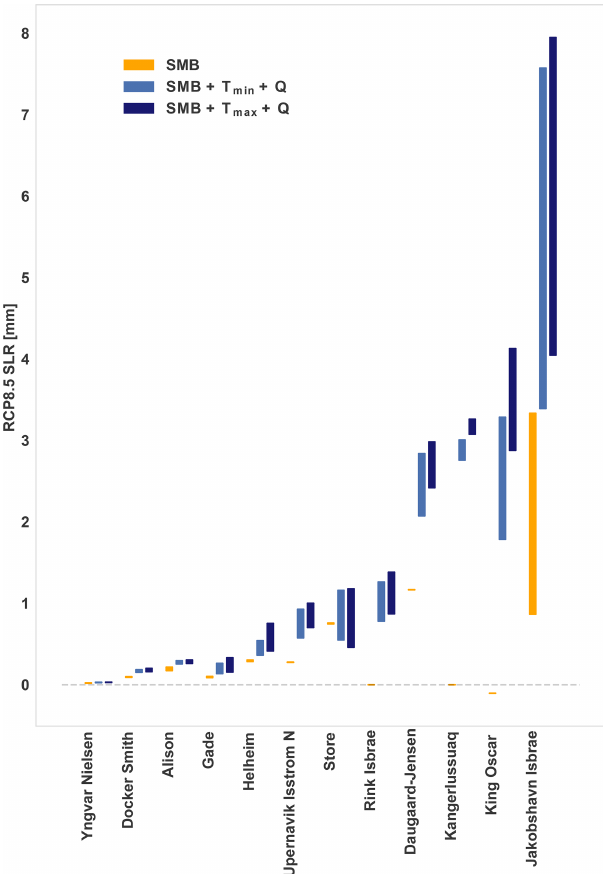
Figure 12. First to third quartiles of contribution to SLR for each glacier. Future RCP8.5 scenarios were forced with either SMB changes only (orange) or changes in SMB, ocean temperature ( T min and T max ) and subglacial discharge